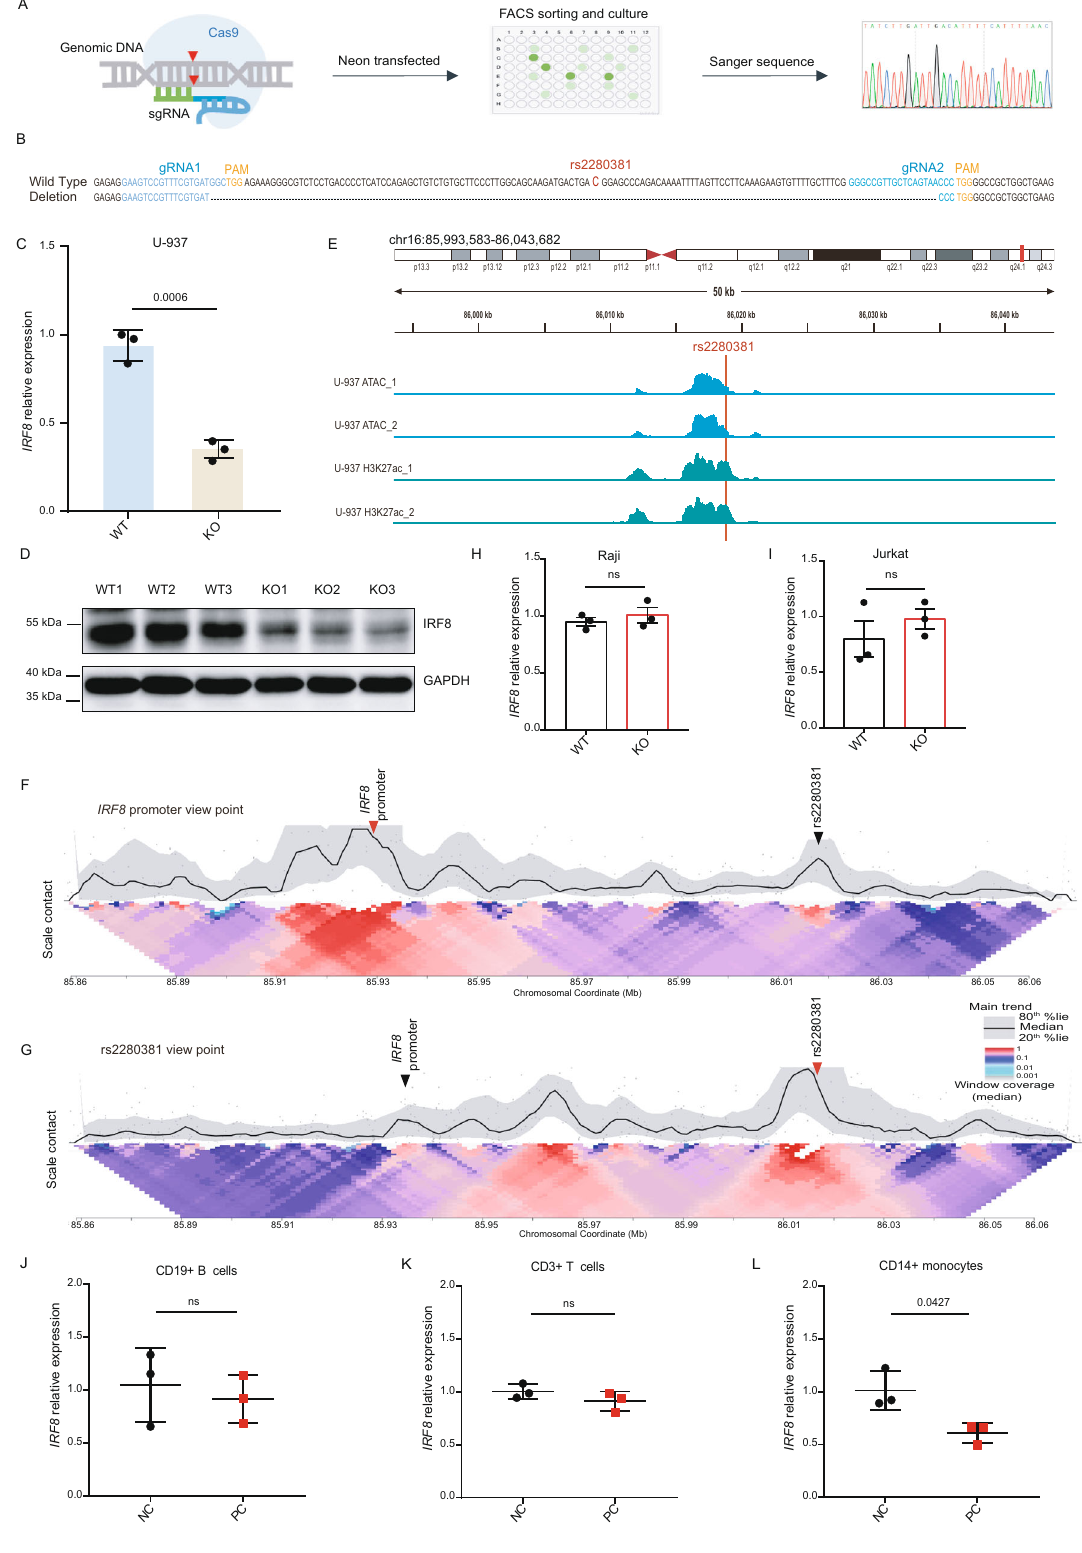
qPCR (Fig. 4A). Five pairs of PCR primers were designed relative to the IRF8 transcription start site from − 1000 to + 153, including all regions with high chromatin accessibility assessed by ATAC-seq (Supplementary Fig. 7A). The AC092723.1 probe was fi rmly and enriched explicitly for AC092723.1 RNA compared to the control NEAT1 (Fig. 4B, C and Supplementary Fig. 7B,